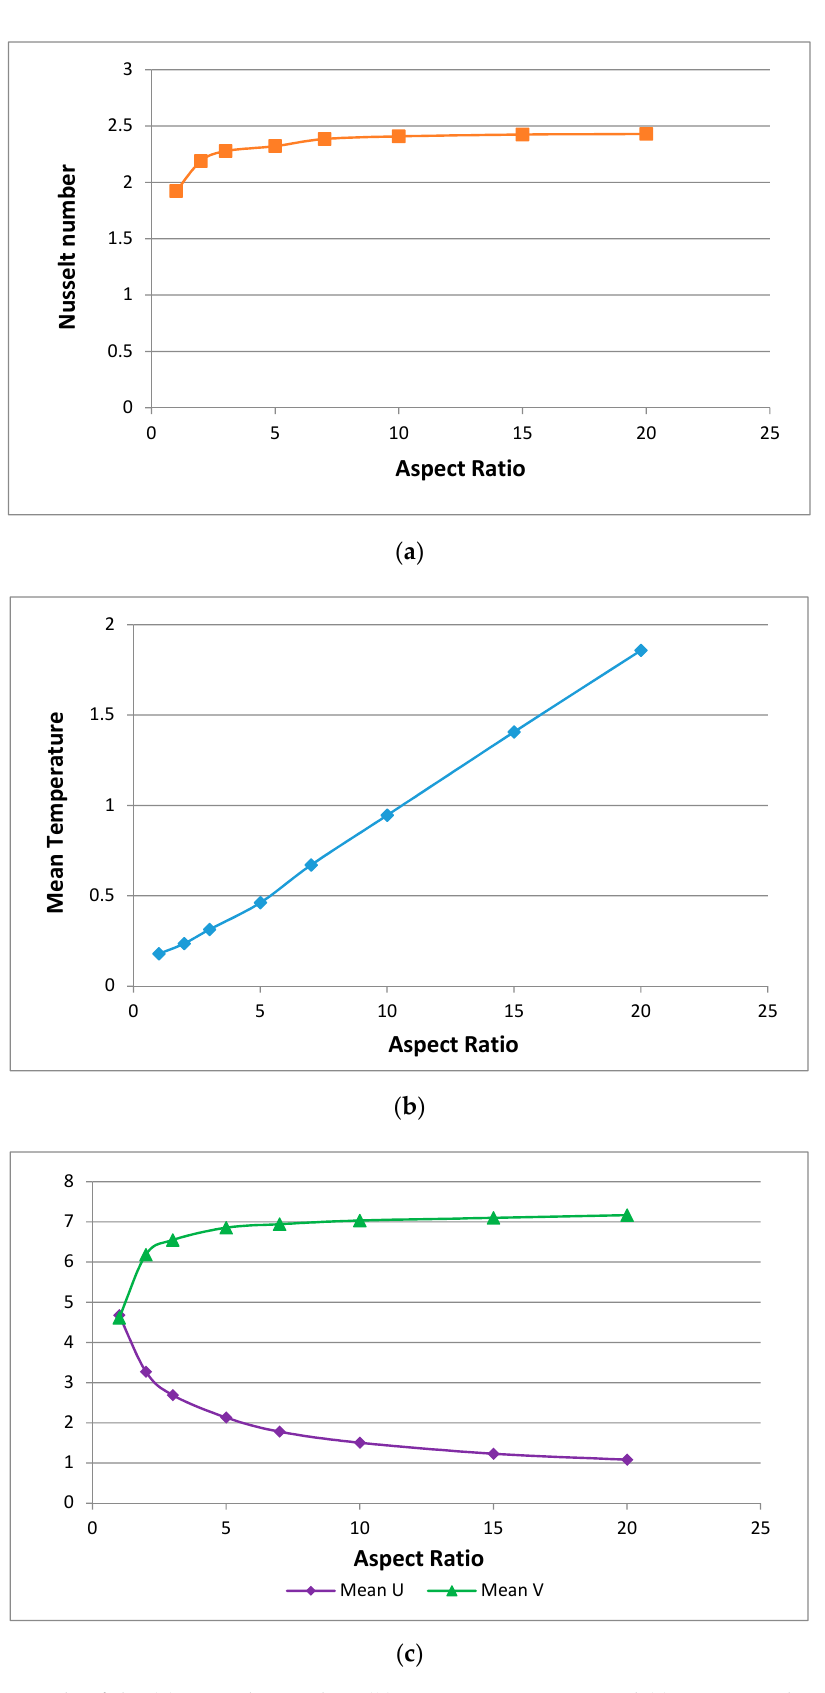
Figure 2. Trends of the ( a ) Nusselt Number; ( b ) mean temperature; and ( c ) mean amplitude of the velocity components vs. the aspect ratio.